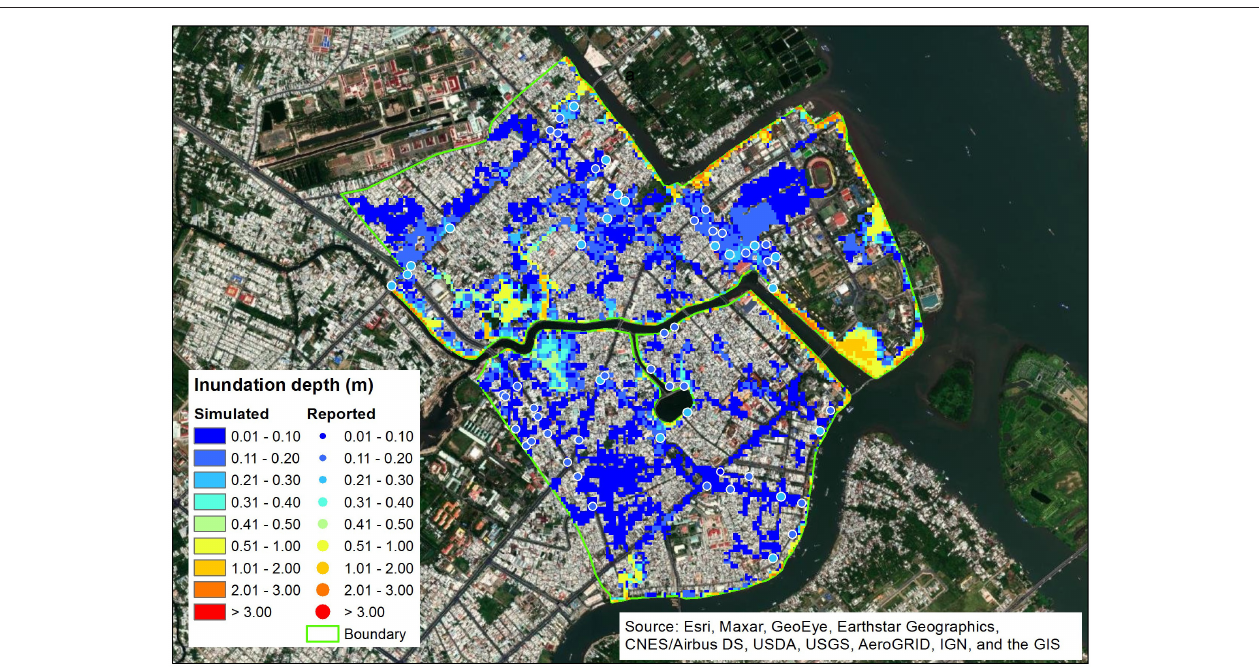
FIGURE 8 | Flood inundation map (flood extent and the maximum simulated inundation depth) and the measured inundation depth (dots) at streets in Ninh Kieu district corresponding to the flood event October 2016.